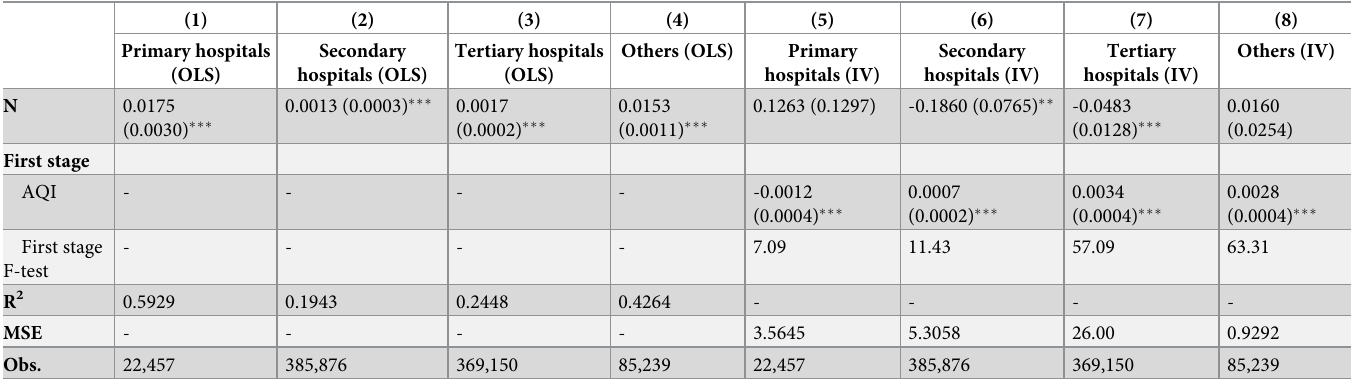
Table 5. Regression results of log length of stay for different hospital tiers.